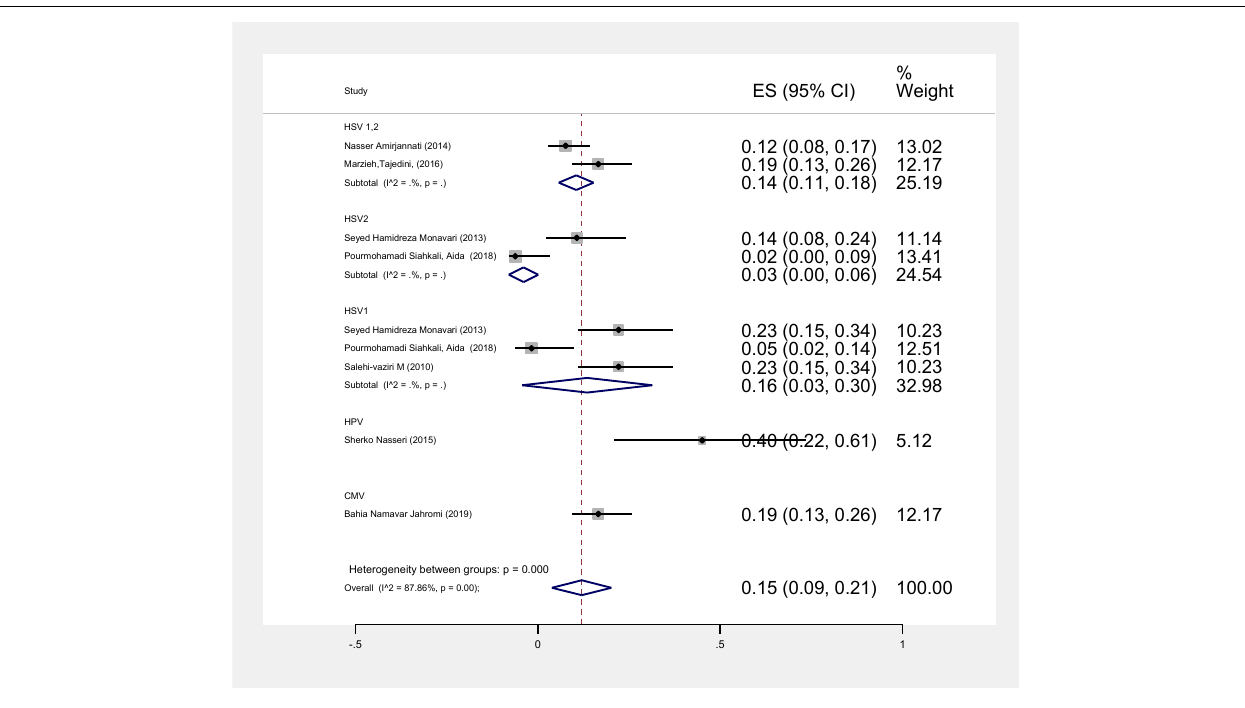
FIGURE 5 | Estimating the prevalence of viral agents in each of the initial studies and pooled estimate with a 95% confidence